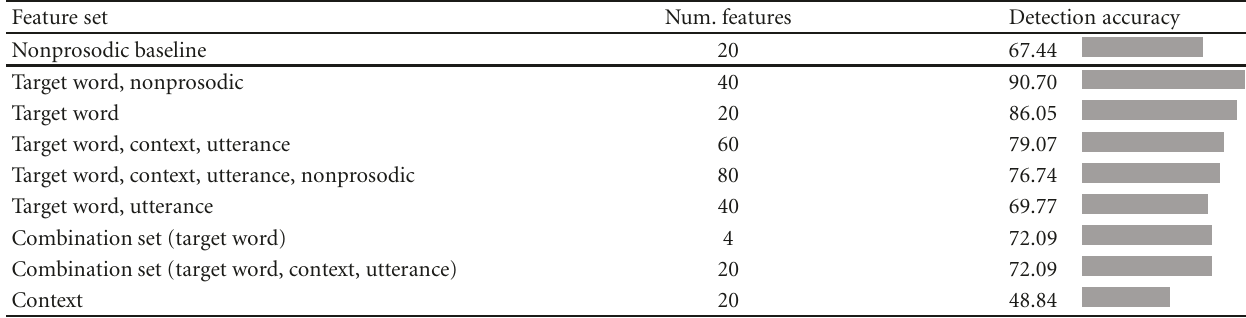
Table 7: Accuracies on the task of identifying the word or phrase causing uncertainty when choosing between the actual word and a control word. The model that was trained on the set of target word features and nonprosodic features achieves 91%